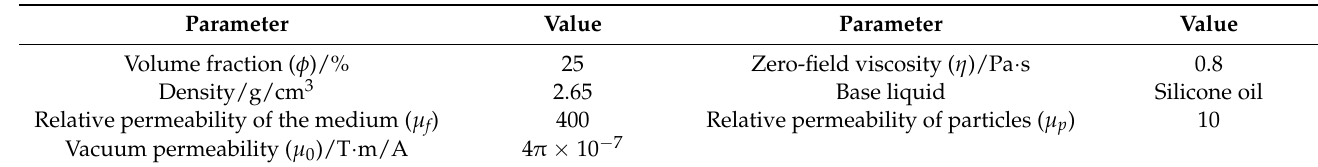
Table 2. MRF (MRF-J01T) material performance parameters.